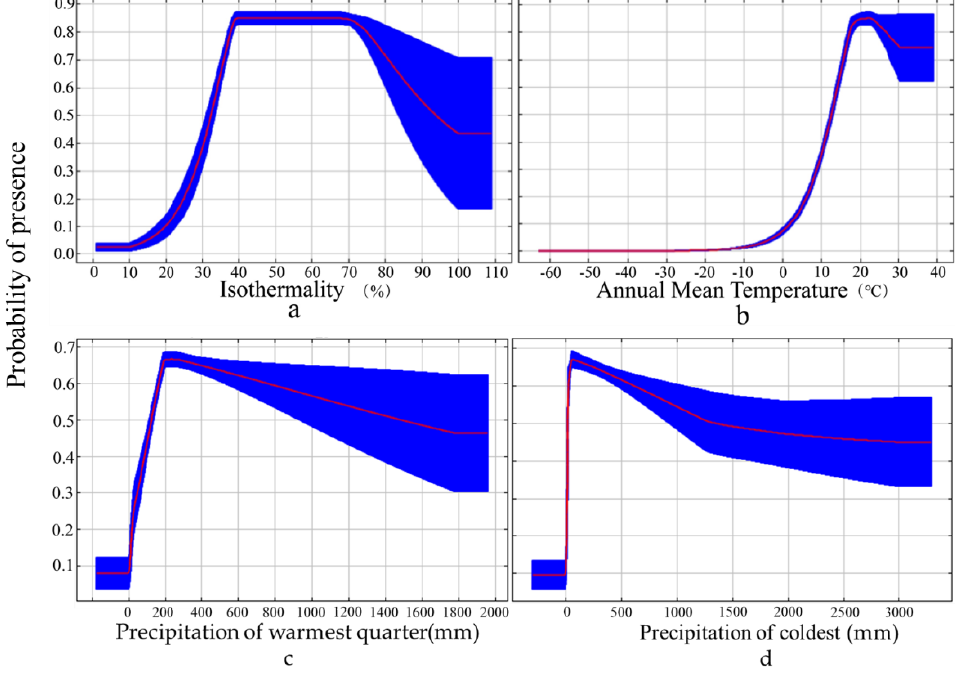
Figure 4. Response curves of the bioclimatic variables most related to the distribution of Anthonomus grandis : ( a ) bio3 (Isothermality); ( b ) bio1 (Annual Mean Temperature); ( c ) bio18 (Precipitation of warmest quarter); ( d ) bio19 (Precipitation of warmest quarter).